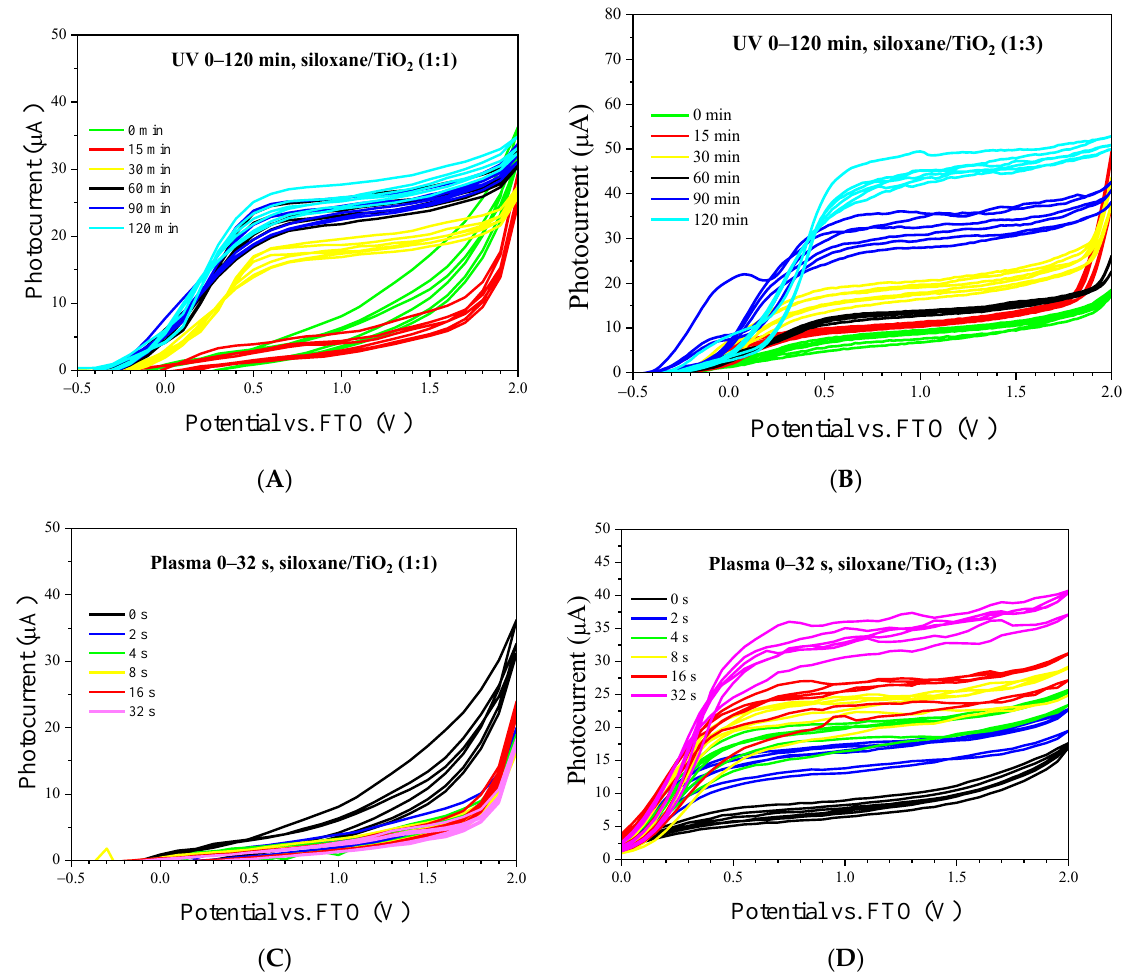
Figure 7. Voltammetric characterisation of TSC printed on FTO-coated glass. ( A , B ) are images for samples treated with UV-irradiation; ( C , D ) are images for plasma-treated samples. Plasma can not penetrate the layer sufficiently if it contains too much siloxane. In the case of ( C ), the photocurrent is very low to zero.